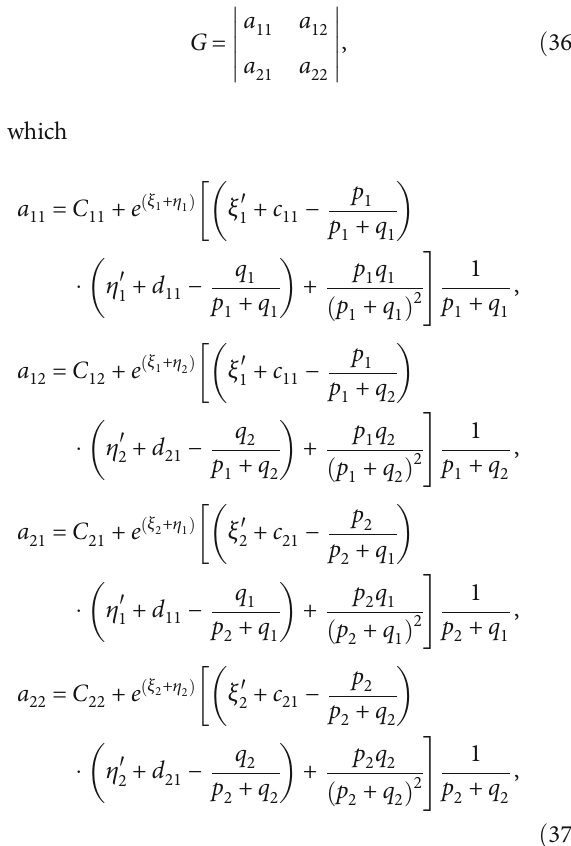
Figure 5: The high-order semirational solution u = 2 ln ð G Þ d 12 = 1 , C 11 = 1 , ξ 10 = η 10 = 0 : (a) t = − 1/2 , (b) t = 0 , and (c) t = 1/2